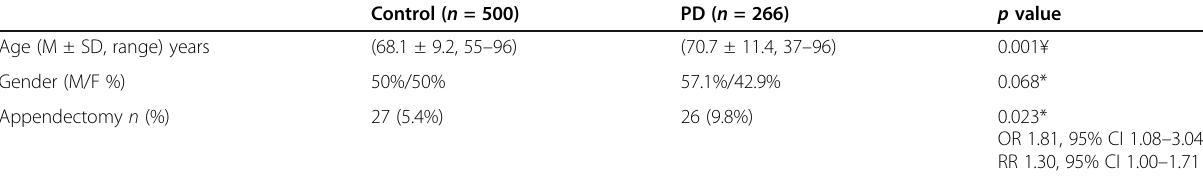
Table 1 Comparison between PD and control patients